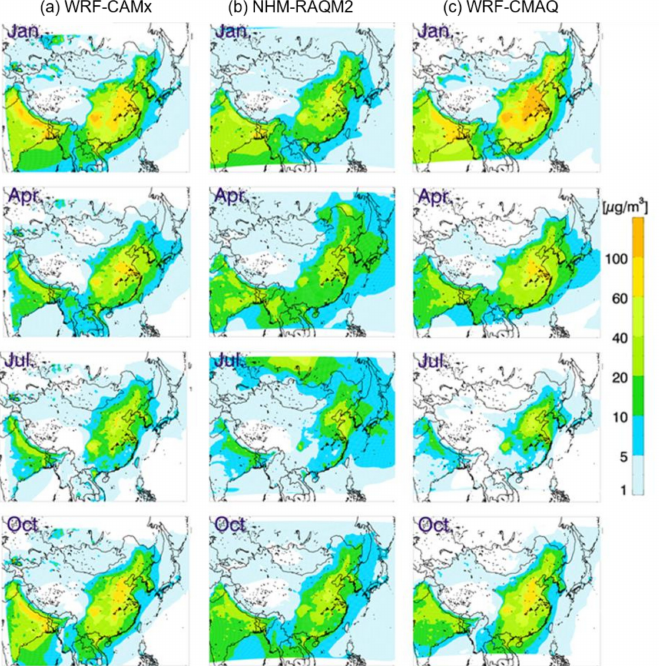
Figure 2. Spatial distributions of monthly average PM 2.5 concentrations ( µ g/m 3 ) for January, April, July, and October 2013. The three air quality models are ( a ) WRF-CAMx, ( b ) NHM-RAQM2, and ( c ) WRF-CMAQ, employed by China, Japan, and Korea,